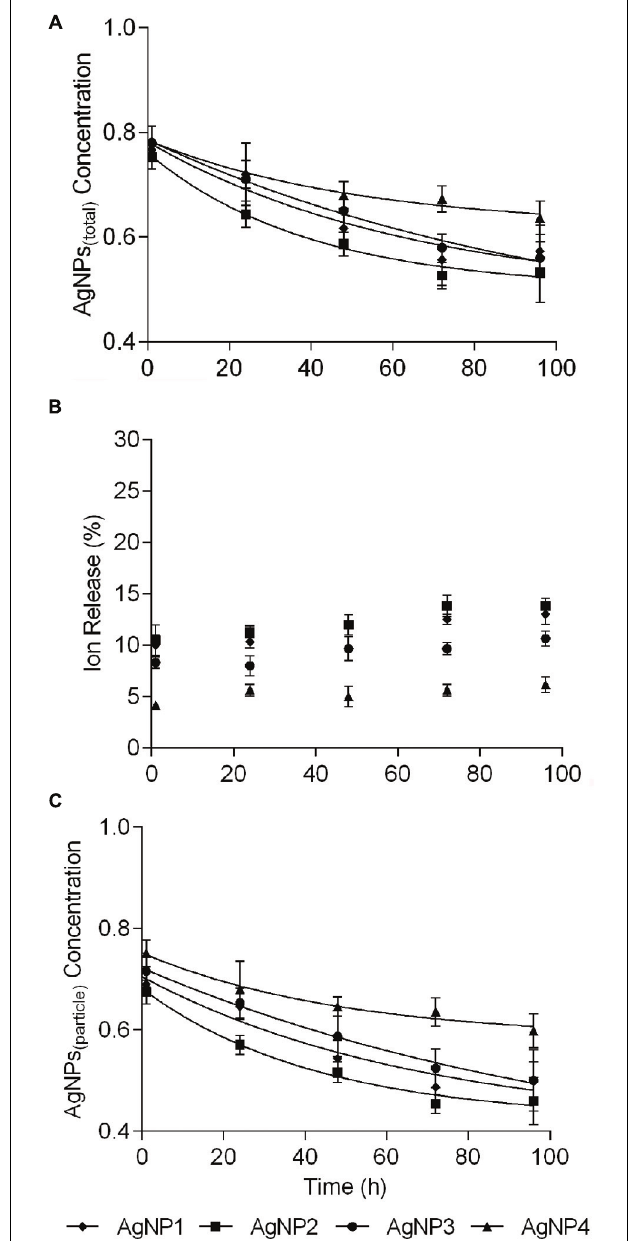
FIGURE 1 | Ion release profiles of silver nanoparticles (AgNPs) at 1 mg/L, during 96 h of incubation in the exposure medium. (A) Total Ag concentrations of the AgNPs ( total ) . (B) Relative percentage of dissolved Ag released from AgNPs. (C) Ag concentrations of the AgNPs ( particle ) . Data are mean ± SD ( n = 3). (AgNP1:50–80 nm nanoplates, AgNP2:15 nm nanospheres, AgNP3:20–40 nm nanospheres, and AgNP4:50 nm